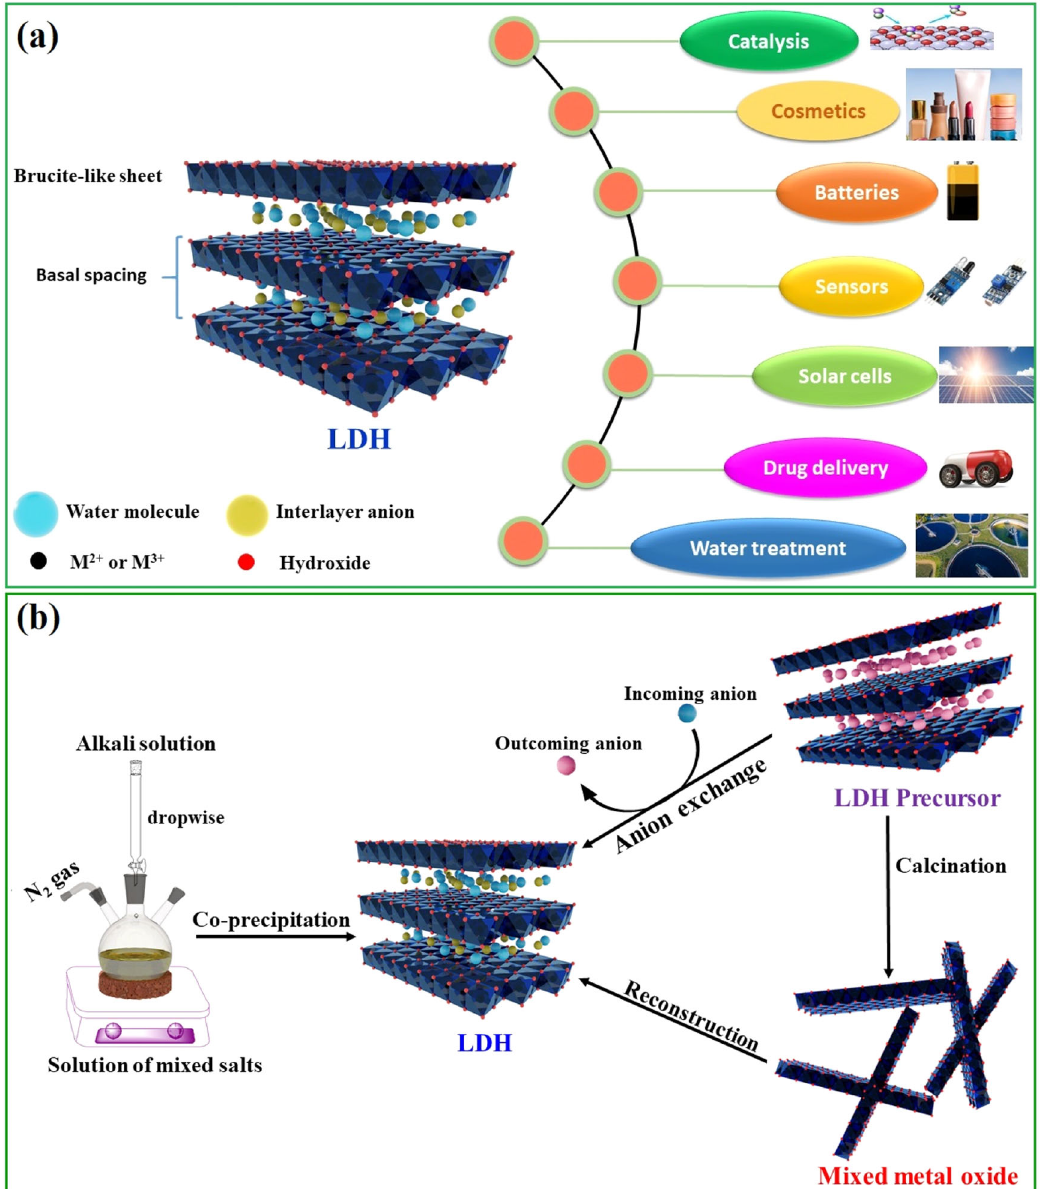
Fig. 1 Chemical structure of LDHs and their common preparation methods and applications. a The structure and bountiful applications of LDHs, and b Schematic illustration of the three superior preparation routes of